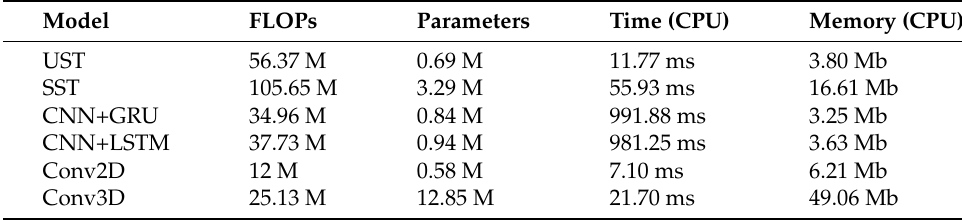
Table 8. Temporal and spatial consumption of the six